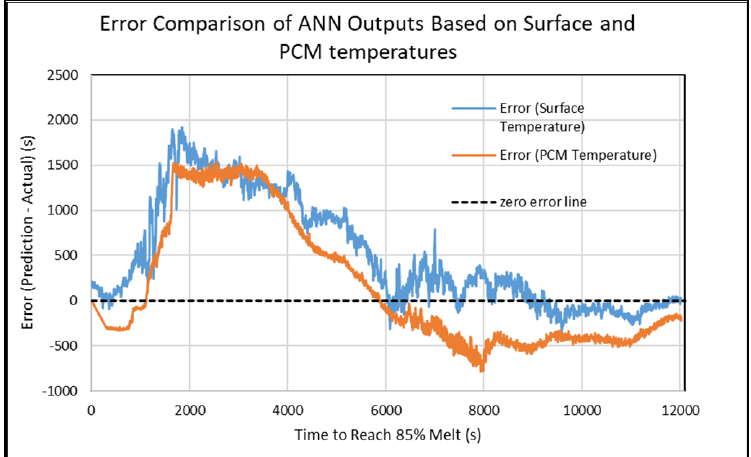
Figure 17. Comparison of error in predictions from the ANN model trained using transient surface- temperature data and transient PCM-temperature data (for test data set of 2.6 V and training data set of 2.8 V).